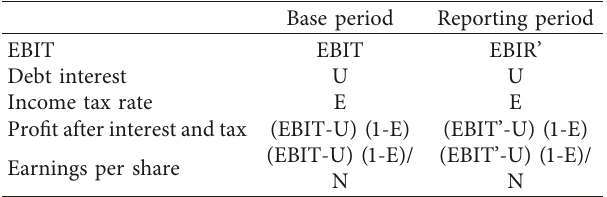
Table 1: DFL value calculation